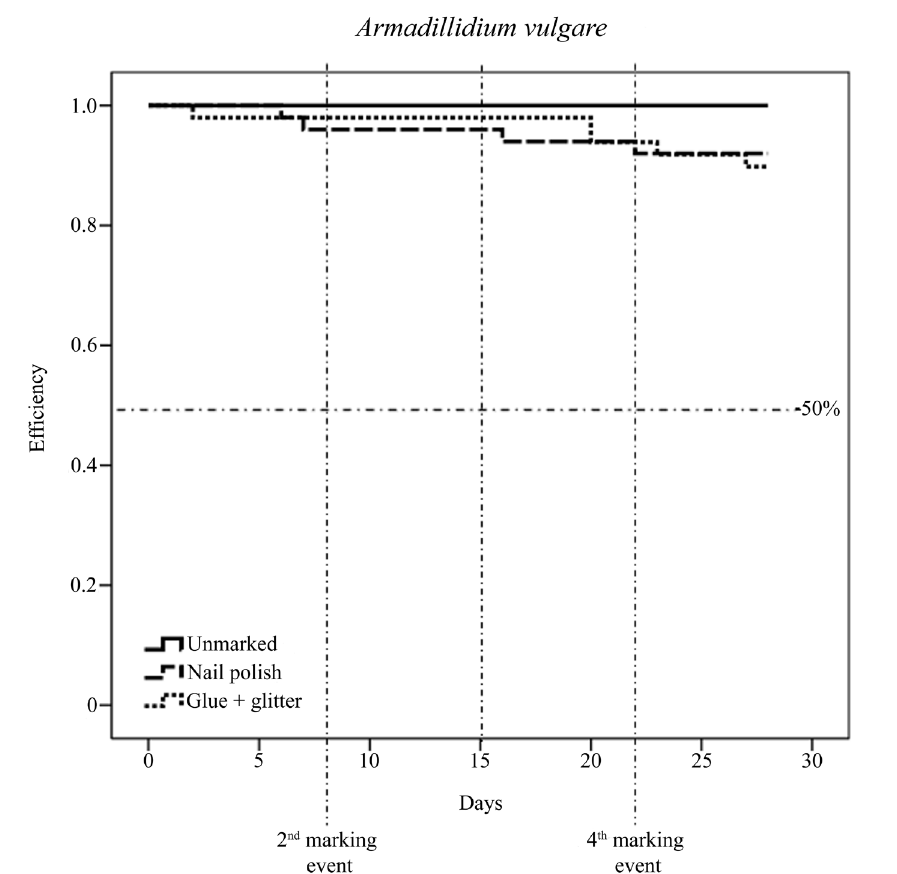
Figure 2. Kaplan-Meier curves for the external marking efficiency (durability) of the two materials tested on Armadillidium vulgare for 28 days of observation. Vertical dotted lines indicate the second, third and the forth event of external marking (8 th , 15 th and 22 th days, respectively). Horizontal dotted line delimits the 50% of remaining marked